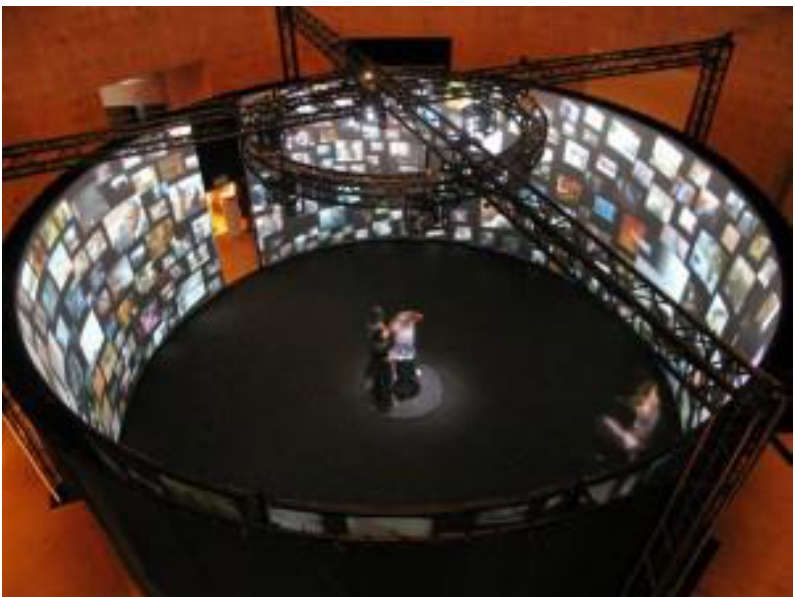
Figure 1. T-visionarium , International Documentary Film Festival Amsterdam,